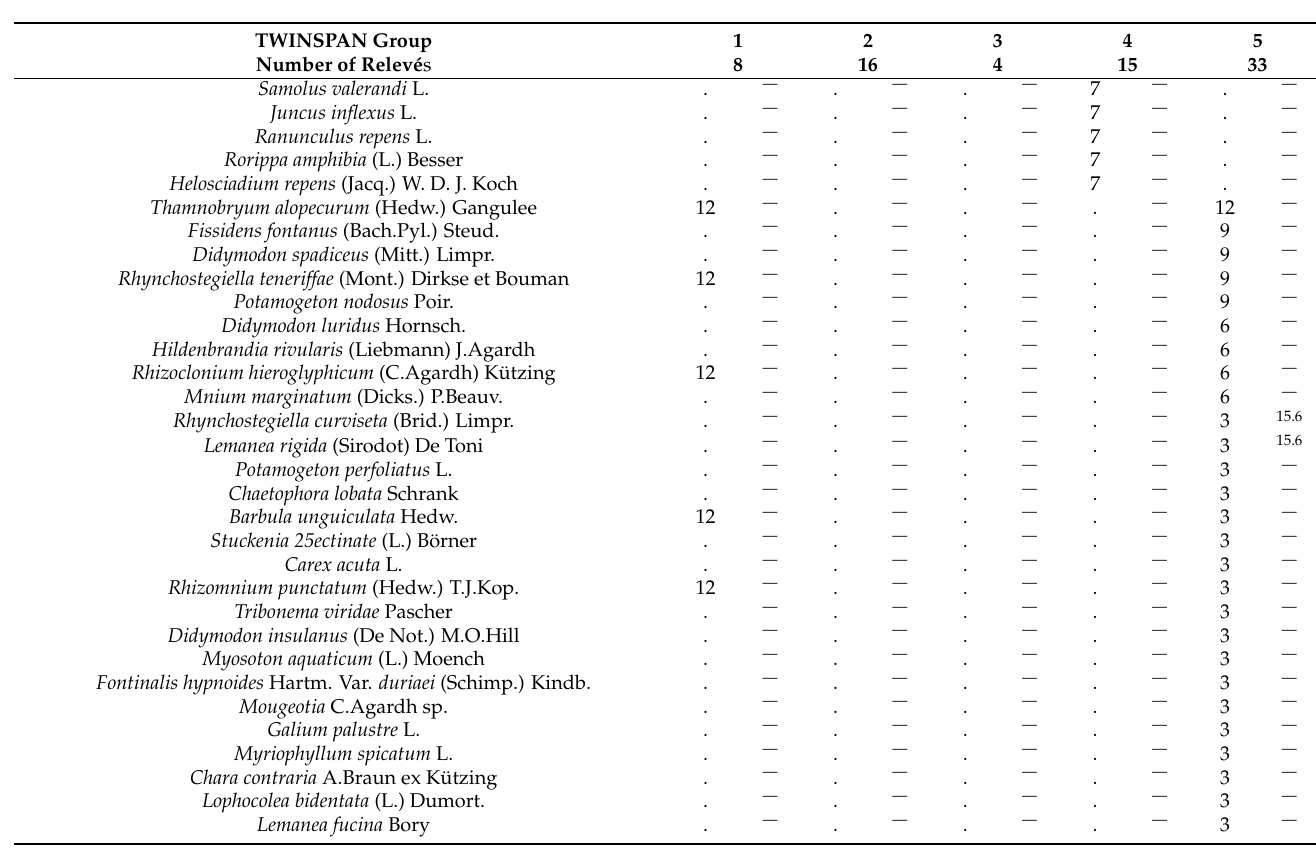
Table A1. Cont. TWINSPAN Group